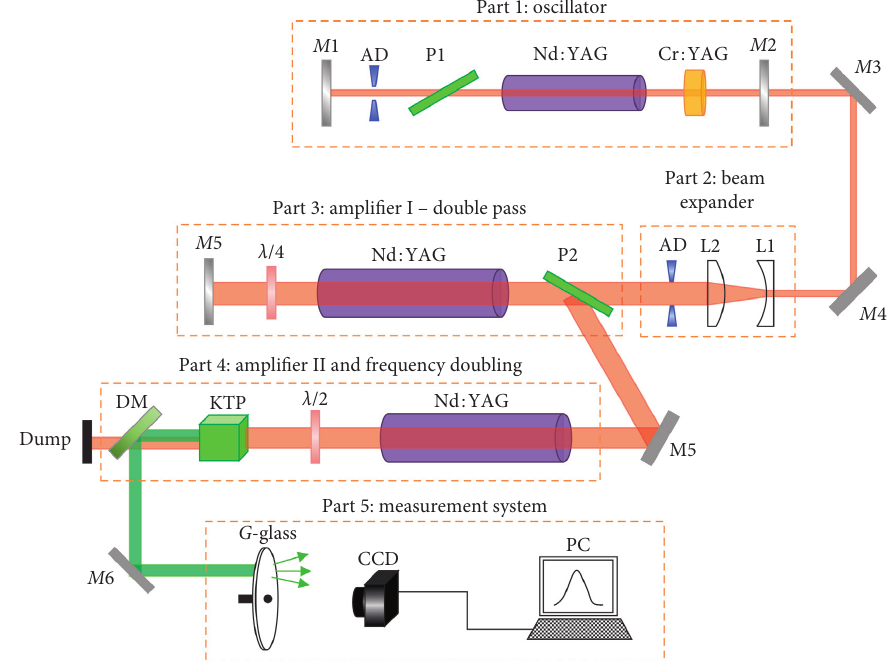
Figure 1: Schematic of the high-visibility pseudothermal ghost imaging laser experiment